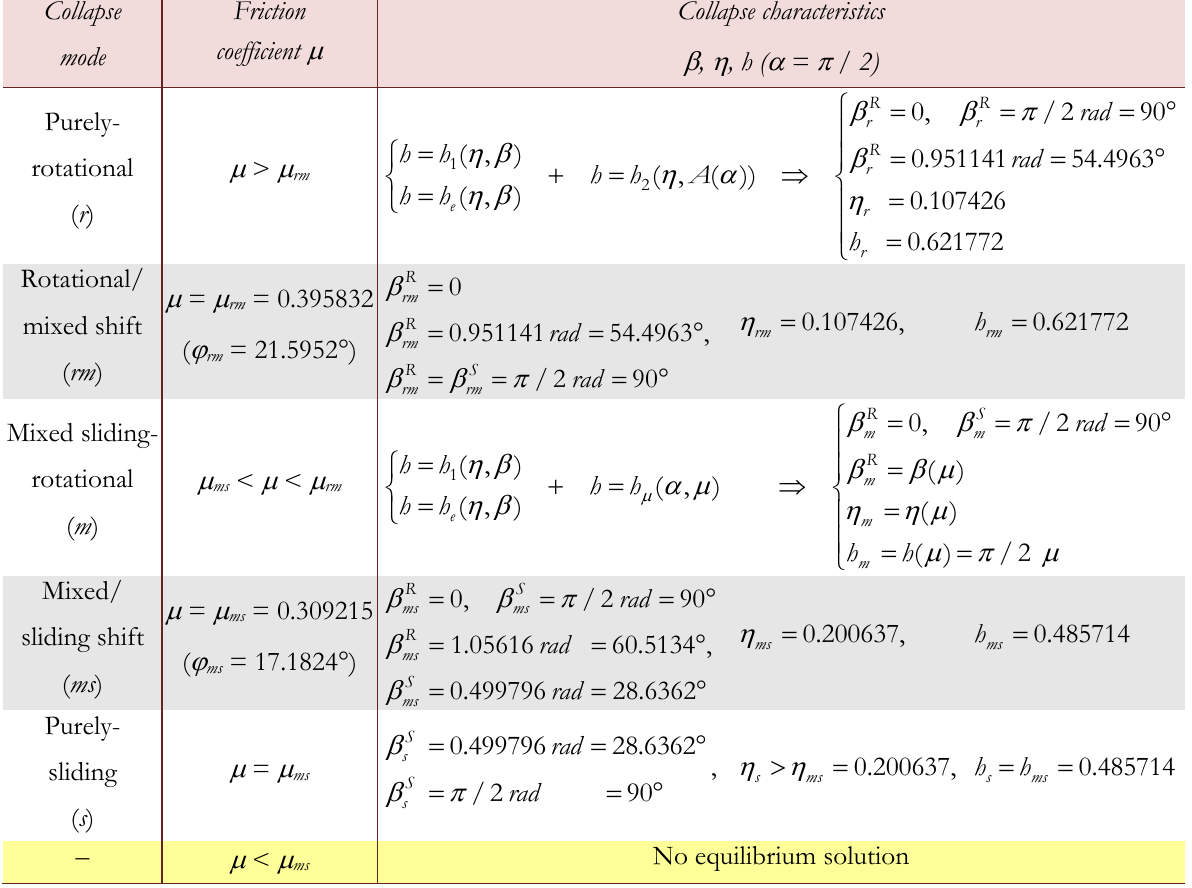
Table 3: Summary of analytical collapse characteristics at variable friction coefficient  for the complete semi-circular arch with 2  =  (refer also to Fig.